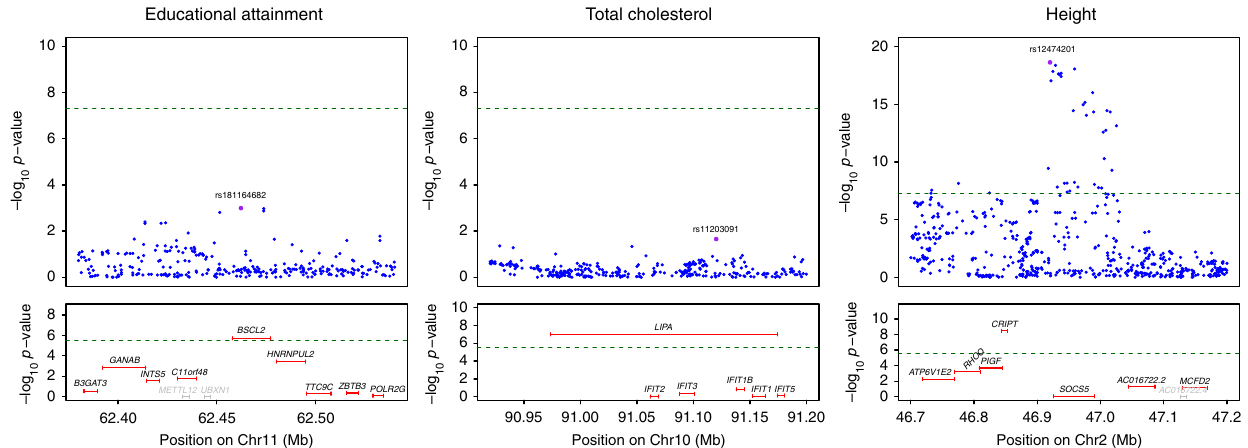
Fig. 2 Regional association plot for GWAS and TWMR analyses. Top panels show single-SNP association strengths ( y axis shows the − log 10 ( p value)) versus genomic position (on hg19/GRCh37 genomic build; x axis) around the most signi fi cant SNP, indicated with a purple dot. Lower panels illustrate gene causal association strengths (y axis shows the − log 10 ( p value)) versus genomic position. Genes highlighted in gray were not tested (i.e., they do not pass the heterogeneity test or not have signi fi cant eQTLs). Green dotted lines represent GWAS and TWMR signi fi cance thresholds. Note that for educational attainment and total cholesterol the most signi fi cant SNP did not reach GW signi fi cance (top), whereas TWMR pinpoints to putative causal genes